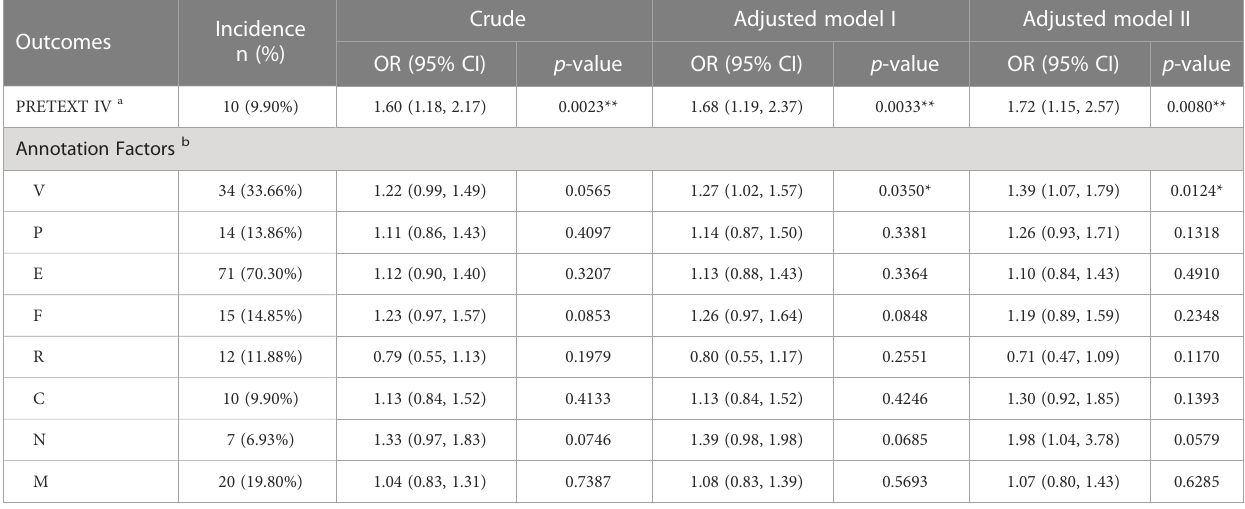
TABLE 3 The effect of SUA on PRETEXT staging and annotation